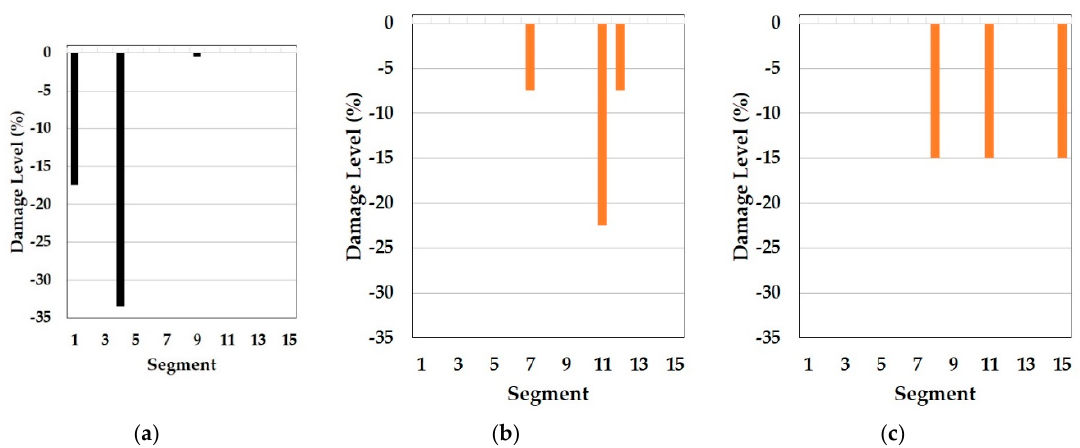
Figure 14. Independent baseline model under DS3 (blue color is correct segment whereas orange color is incorrect segment): ( a ) Predicted damage from the GA (black color); ( b ) top one damage case using the first to fourth natural frequencies; ( c ) top two damage case the first to fourth natural frequencies.